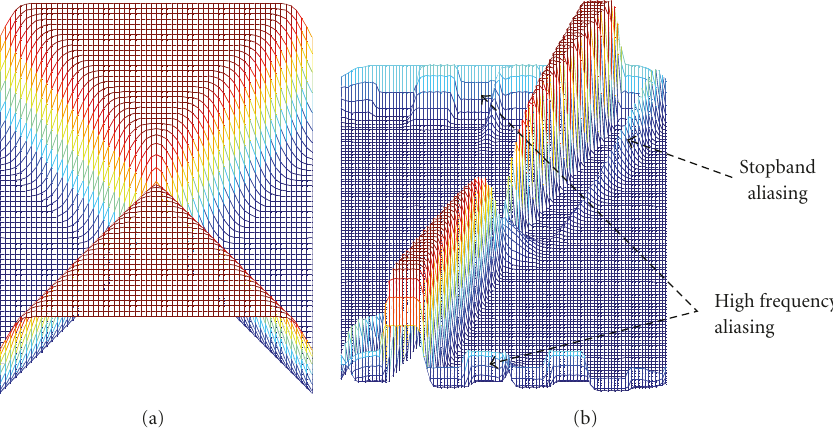
Figure 10: The frequency responses of (a) a fan filter with very small transition band, and (b) the directional band of a sixteen-band DFB created from the fan filter of